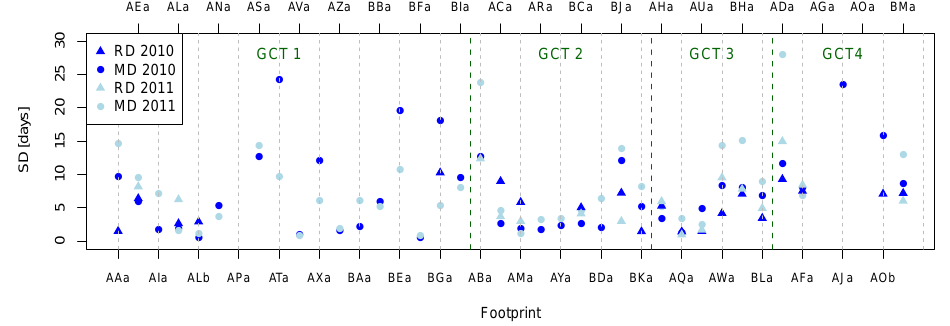
Fig. 6. Standard deviation (SD) for the RD and the MD per footprint for both measuring years. The locations are ordered by their ground cover type (GCT).